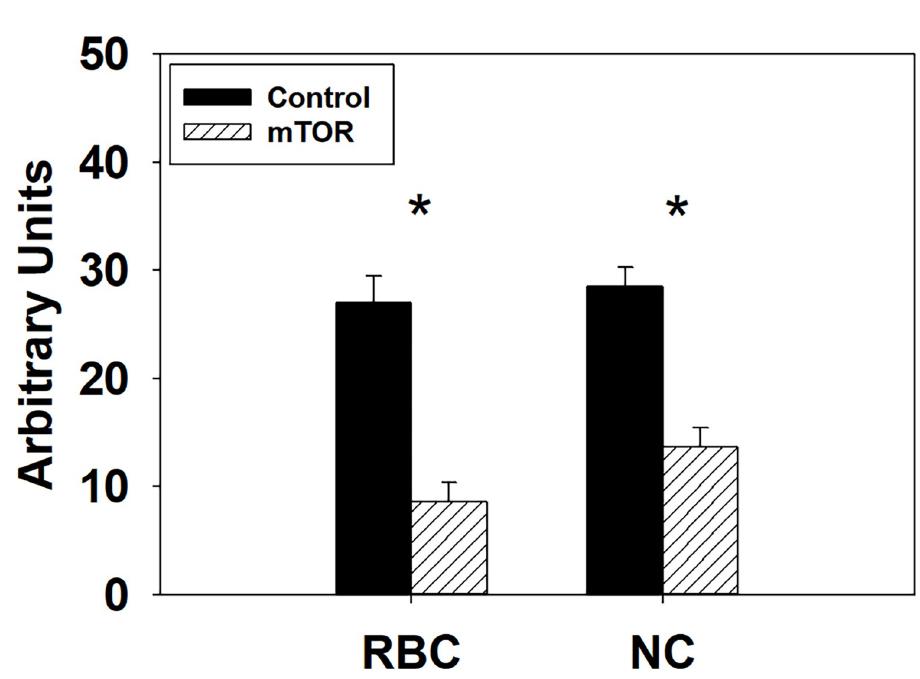
Fig 3. Knockdown efficiency of the mTOR siRNA. Relative expression of mTOR as determined by RT-qPCR at 72 h of proliferation after knocking down mTOR with small interfering RNA at the beginning of proliferation in SCs from the RBC2 and NC turkeys. Asterisk ( � ) above the bars represents a significant difference between the two adjacent groups ( P � 0.05).